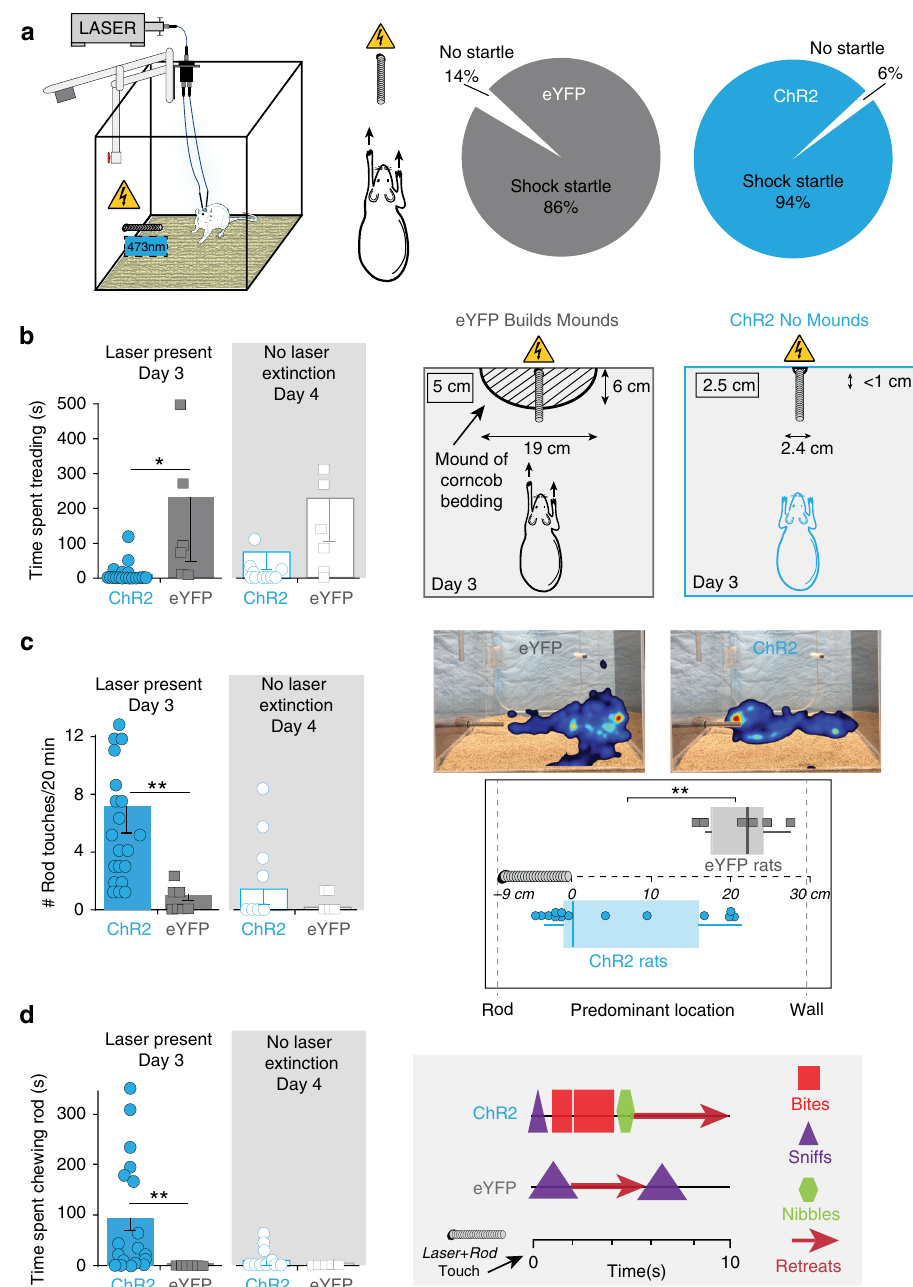
Fig. 3 CeA paired stimulation creates attraction toward aversive shock rod. a Apparatus: electri fi ed shock rod protruded ~9 cm out from wall into plexiglas chamber. CeA laser illumination was paired with shock-rod encounters (when rat was within <2-cm proximity). Startle probability (i.e., paw withdrawal or jump) when touching the shock rod during the fi rst encounter (ChR2, N = 16 vs. eYFP, N = 6 two-sided unpaired t -test: t 30 = 0.823, p = 0.42). b Defensive treading on day 3 when laser was present (CeA ChR2 N = 16 vs. eYFP rats N = 6 , two-sided unpaired t -test: t 21 = − 2.4, p = 0.03, 95% CI: 29, 410, d = 0.72) versus when laser was removed on day 4 ( ‘ No Laser Extinction ’ , two-sided unpaired t -test: t 14 = − 1.69, p = 0.16). Drawing depicts defensive treading – burying behavior and consequent mounds of bedding. Placement and size of mounds shown by diameter of striped mound symbol (ChR2 vs. eYFP two-sided unpaired t-tests: height: t 26 = − 4.3, p = 0.000, 95% CI: − 3.5, − 1.2, d = 1.73; length: t 26 = -5.4, p = .000, 95% CI: − 6.9, − 3.6, d = 2.09; width: t = − 6.5, p = 0.000, 95% CI: − 22.2, − 11.6, d = 2.34). c Shock-rod touches when laser was paired with rod encounters (ChR2 rats, N = 26 16 vs. eYFP rats, N = 6, two-sided unpaired t -test: t 23 = 3.6, p = 0.002, 95% CI: − 11.8, − 3.2, 11, d = 1.07), versus on no-laser day (two-sided unpaired t - test: t 11 = 1.18, p = 0.26). Representative heatmaps (right) for individual rats shows location of representative rats during 20-min session (ChR2 or eYFP). Boxplots show predominant location: middle lines depict median (center), outer left lines extend to minimum value, outer right lines extend to maximum, and bounds of each box depict quartiles 2 – 3 (middle 50% of data; ChR2 rats, N = 14 vs. eYFP rats, N = 6, two-sided unpaired t -test: t 18 = − 3.8, p = 0.001, 95% CI: − 25, − 7.2, d = 2.11). d Time spent chewing shock rod with laser present (ChR2 rats, N = 16, eYFP rats, N = 6, two-sided unpaired t -test: t 18 = − 3.3, p = 0.004, 95% CI: − 140, − 30, d = 1.06) versus when laser was removed (two-sided unpaired t -test: t = 0.9, p = 0.38). Right panel shows 11 microstructure choreograph of consummatory behaviors toward the shock rod from a representative ChR2 rat (top) and eYFP rat (bottom) during 10-s period following a shock rod touch. All data represent means and SEM. cm, centimeters. * p < 0.05, ** p <